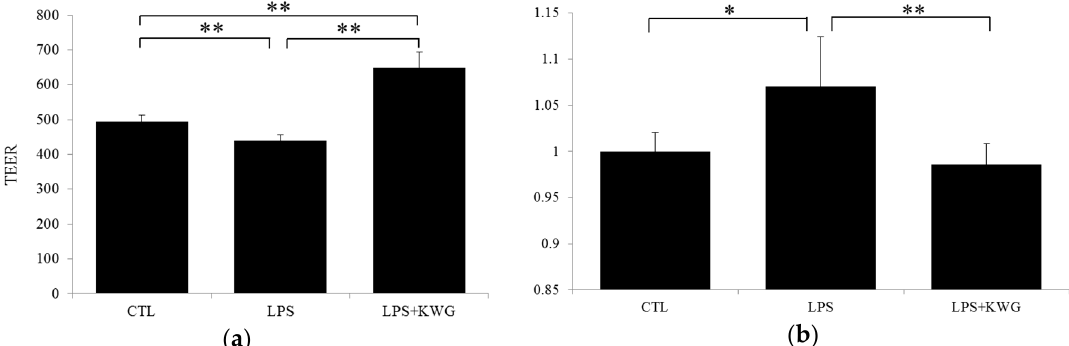
Figure 6. KWG reversed LPS-induced gut epithelial cell barrier defect in Caco-2 cells. ( a ) the trans-epithelial electrical resistance (TEER) was measured after the cells were treated with control (CTL), lipopolysaccharide (LPS) or LPS + KWG for 24 h. ( b ) albumin-fluorescein isothiocyanate (FITC) across the epithelial barrier was detected by a microplate reader at the wavelength of 495 nm. The experiment was repeated three times at different time points. * p < 0.05, ** p < 0.01.